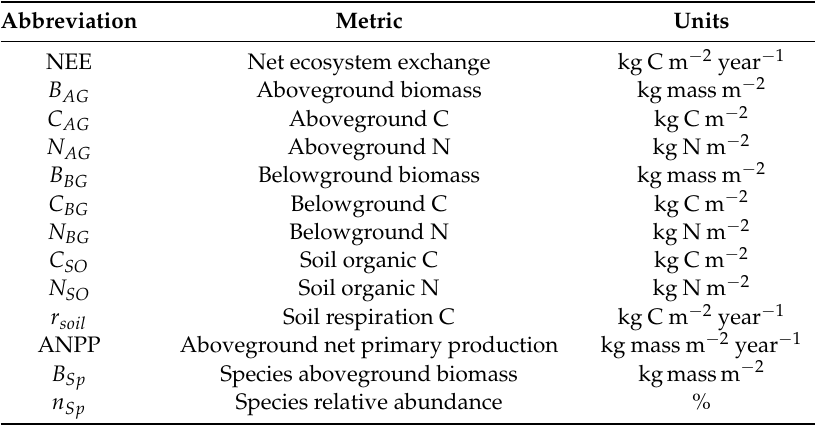
Table 5. Model intercomparison abbreviations, metrics, and